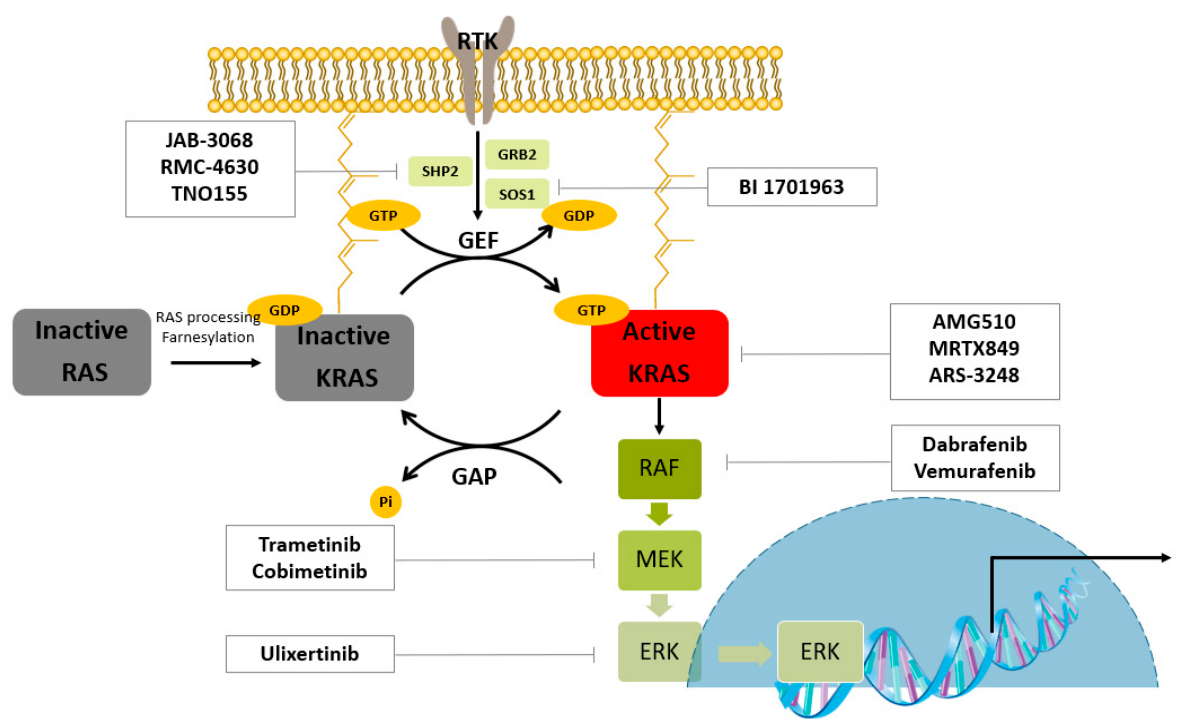
Figure 1. RAS–ERK/MAPK pathway and the representative clinical small molecules for targeted protein degradation. RTK; Receptor tyrosine kinase, GRB2; Growth factor receptor-bound protein 2, SOS1; Son of sevenless homolog 1, SHP2; Src homology-2 domain-containing protein tyrosine phosphatase-2, GEF; guanine nucleotide exchange factor, GAP; GTPase-activating protein, RAF; Rapidly Accelerated Fibrosarcoma, MEK; Mitogen-activated protein kinase, ERK; Extracellular signal-regulated kinase.